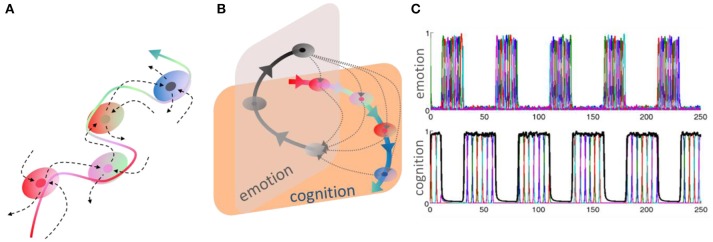
(A) Stable heteroclinic channel (SHC), an invariant topological construction. An SHC is a set of metastable states sequentially connected by unstable seperatrices. The robustness of such channel means that trajectories in the neighborhood of the sequence of separatrices do not leave it until the end of the channel is reached (Rabinovich et al., 2012a, 2015). (B) This panel shows heteroclinic channels representing a recurrent cognitive-emotion interaction—the dotted trajectories illustrate that the interruption of cognitive performance by emotion, which can happen at any cognitive stage. Adapted from Rabinovich and Varona (2017). (C) Time series of sequential switching of emotional and cognitive modalities from model (1)–(2), (Rabinovich et al., 2010b).